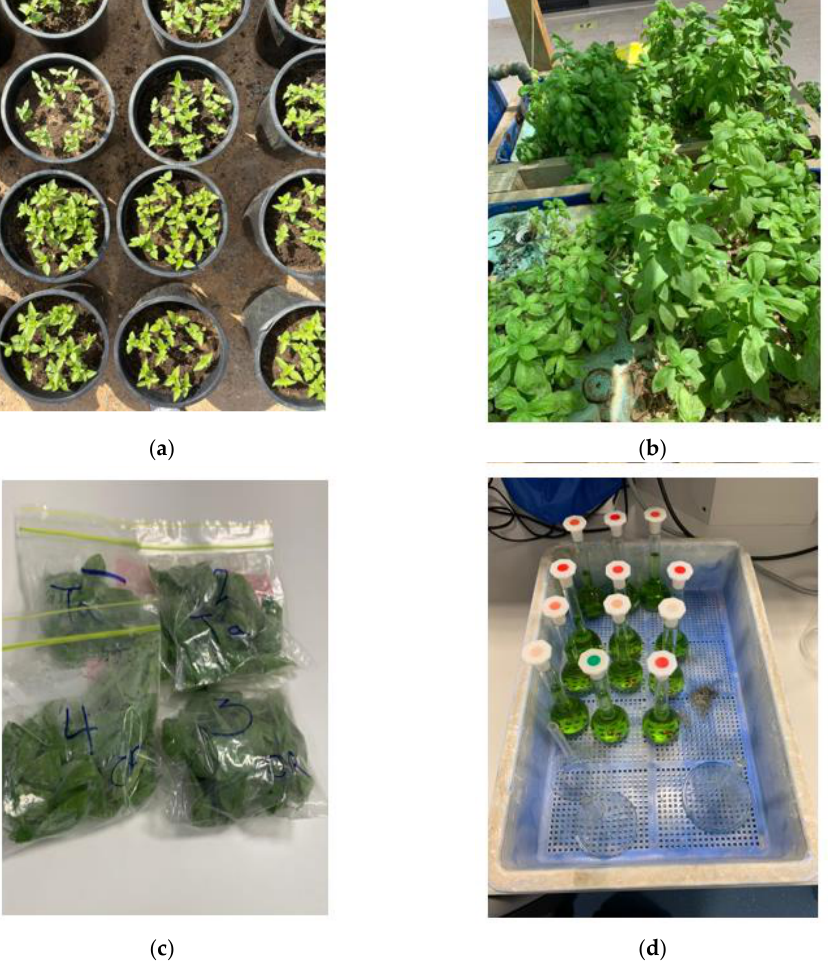
Figure 1. Different stages during the experimental study. ( a ) Early stages of growth in green house, ( b ) growth in aquaponic bed, ( c ) sample collection, ( d ) laboratory analysis.